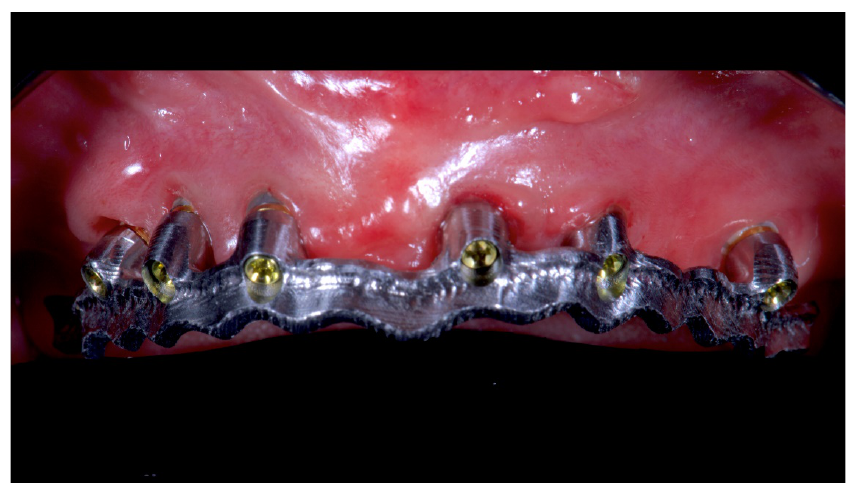
Figure 12. Single frame titanium bar mounted in maxillae with OT Bridge system.